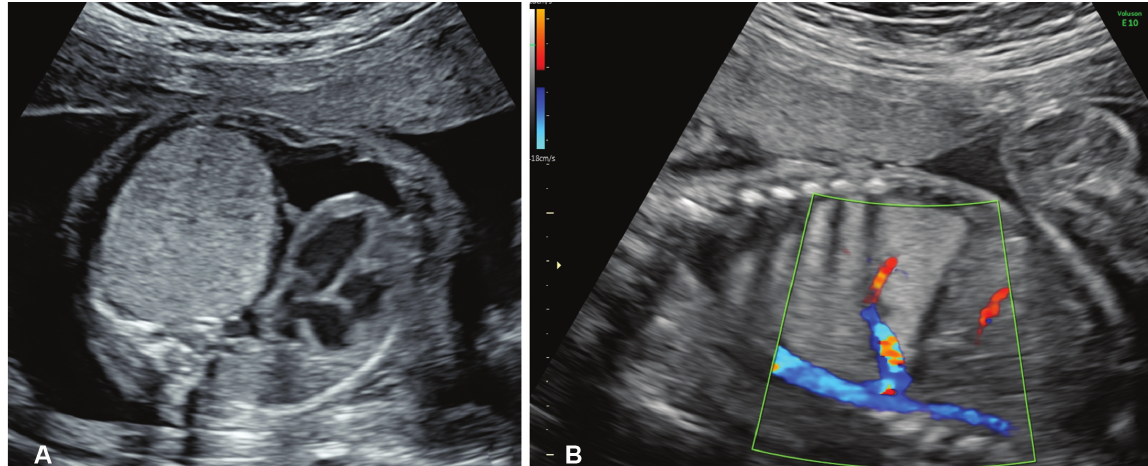
Fig. 3 Prenatal images of patient described as case 2. Transverse view of the fetal thorax illustrating a giant solid lung mass with massive mediastinal shift ( A ) and sagittal view of the thorax showing a systemic feeding artery arising from the aorta ( B ).